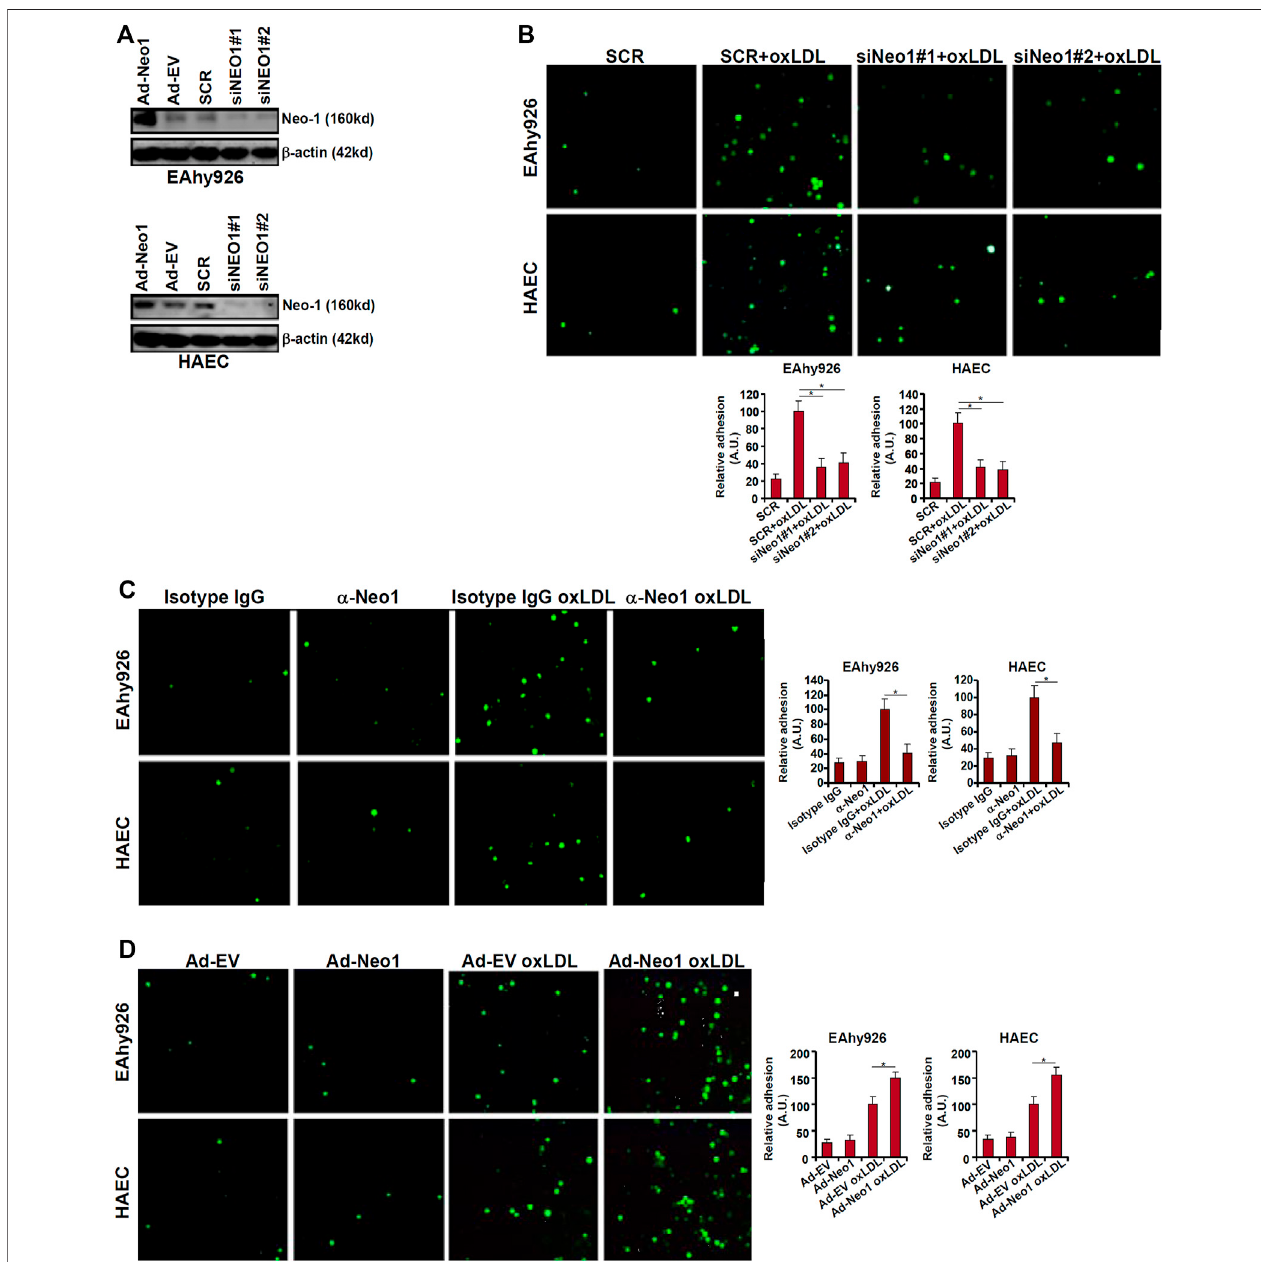
FIGURE2| Neo-1regulatesleukocyteadhesion. (A) EAhy926cellsand HAECsweretransfectedwithindicatedsiRNAs. Alternatively,thesecellsweretransduced with adenovirus carrying a Neo-1 vector (Ad-Neo1) or control adenovirus (Ad-EV). Neo-1 protein levels were examined by Western. (B) EAhy926 cells and HAECs were transfectedwithindicatedsiRNAsfollowedbytreatmentwithoxLDL(50 μ g/ml)for24 h.LeukocyteadhesionwasperformedasdescribedinMethods. (C) EAhy926cells andHAECsweretreatedwithoxLDL(50 μ g/ml)inthepresenceorabsenceofananti-Neo-1antibodyfor24 h. (D) EAhy926cellsandHAECsweretransducedwith adenovirus carrying a Neo-1 vector (Ad-Neo1) or control adenovirus (Ad-EV) followed by treatment with oxLDL (50 μ g/ml) for 24 h. Leukocyte adhesion was performed as described in Methods. SCR, scrambled siRNA.